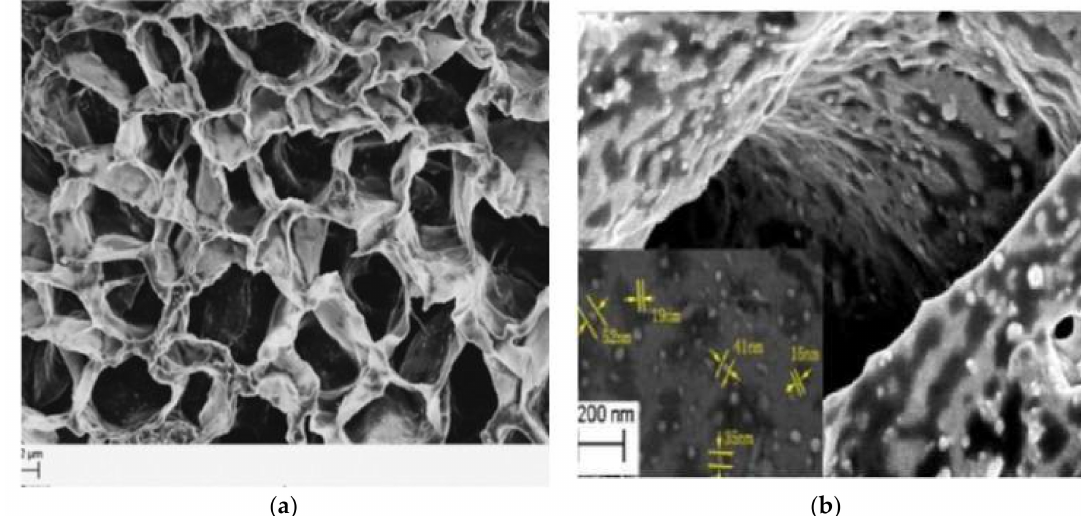
Figure 12. Scanning electron microscopy images of ( a ) cryogel and ( b ) composite cryogel. Republished with permission from [72]. Copyright 2017 Taylor & Francis.